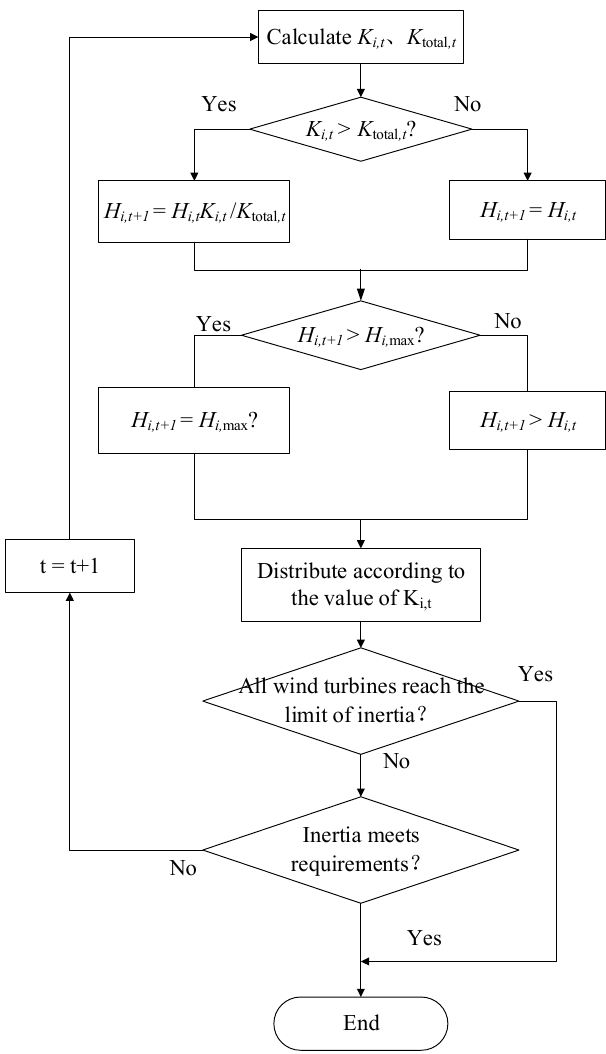
Figure 4. Flow chart of wind turbine inertia adjustment.